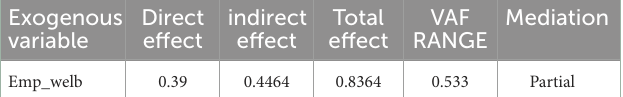
TABLE 4 Mediation analysis